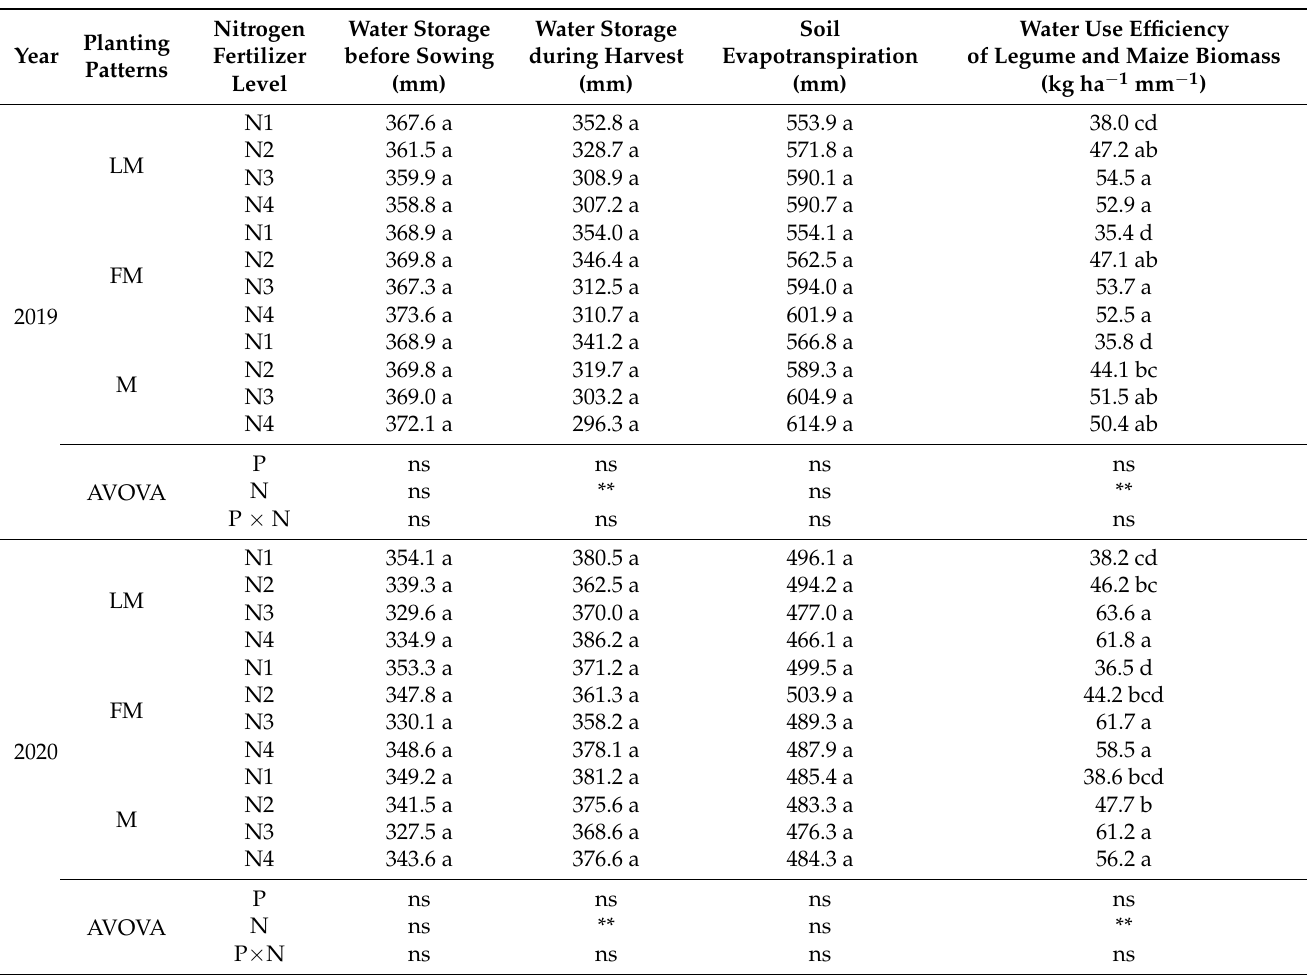
Table 3. Soil water storage, evapotranspiration, and water-use efficiency under different treatments in 2019 and 2020